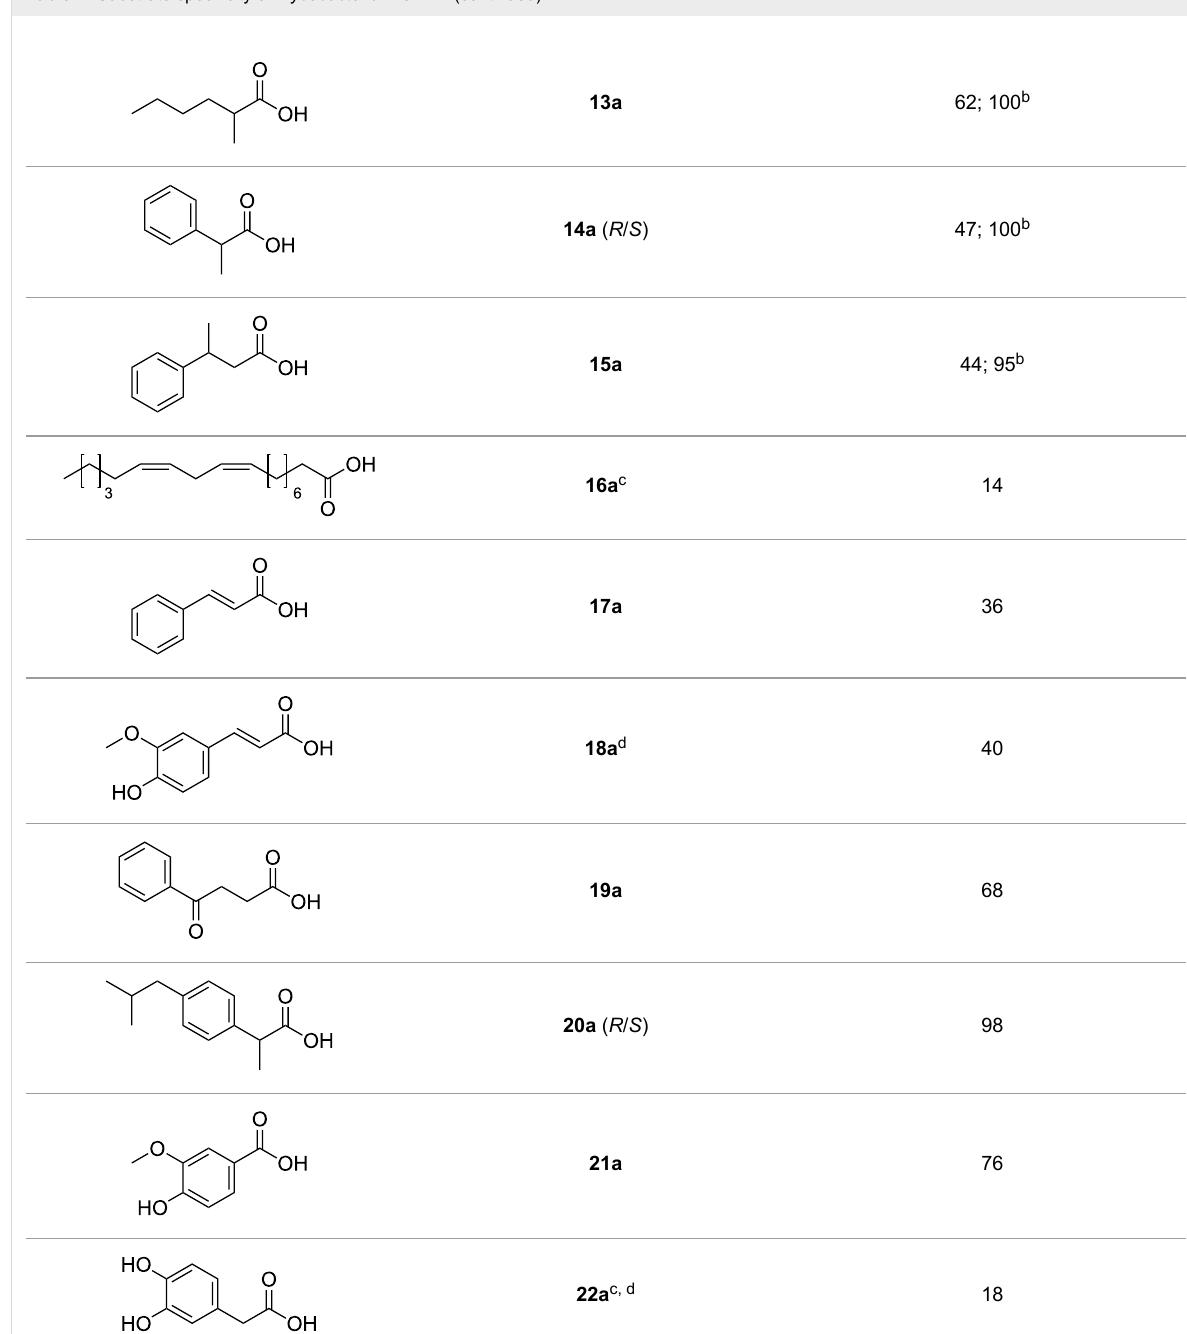
Table 2: Substrate specificity of Mycobacterium CAR a .